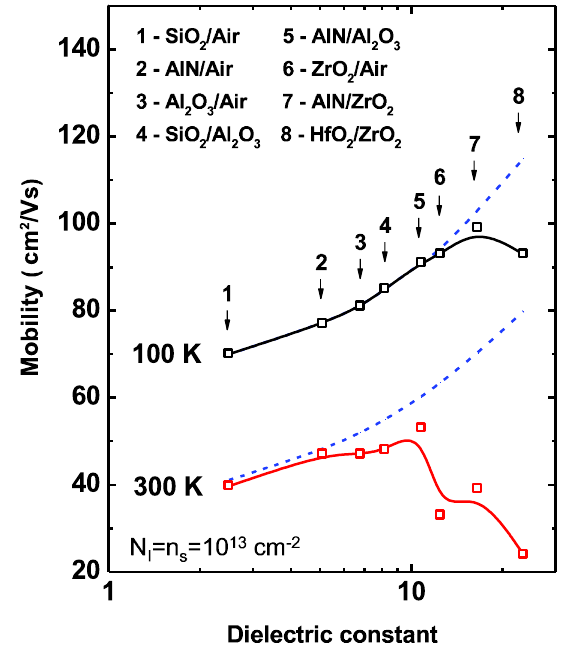
FIG. 5. Electron mobility as a function of an environment dielectric constant. Dashed lines show the mobility without considering the SO phonons.